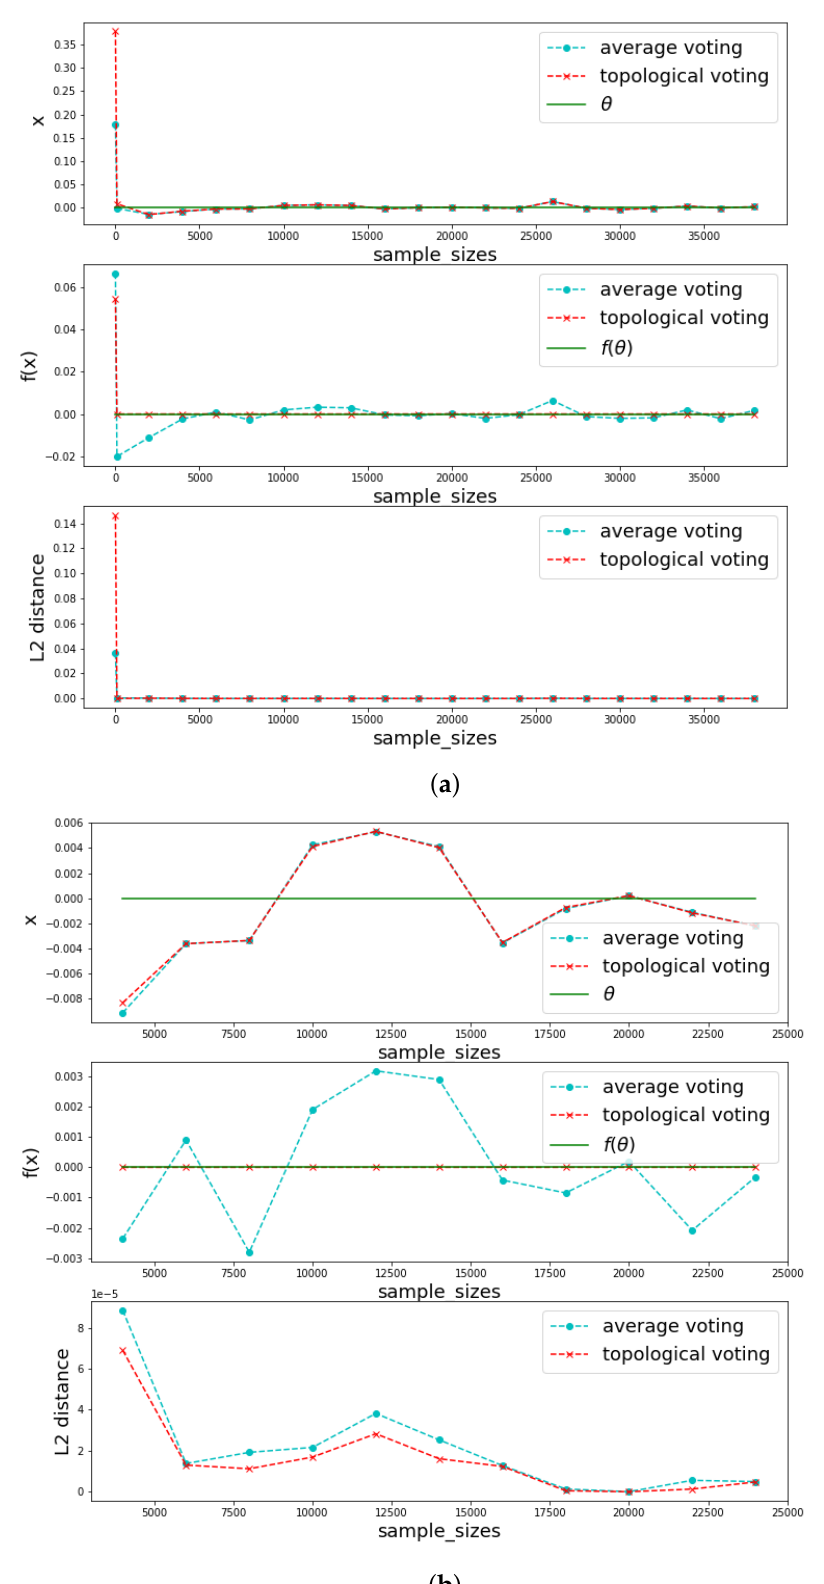
( 1, 1 ) , f ( x ) = x 3 . ( a ) Show for all samples; ∼ U −